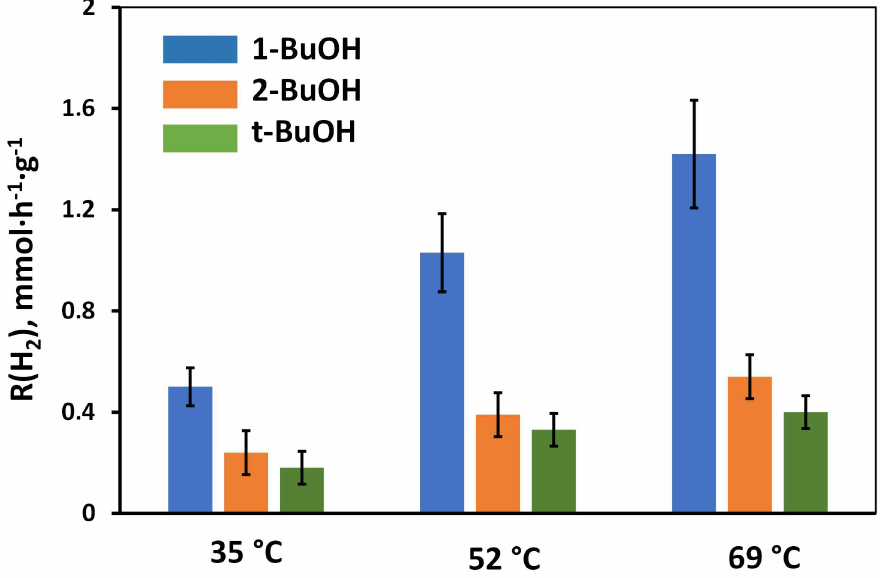
Figure 3. Rate of H 2 production as a function of bulk temperature from 0.5 M aqueous solutions of BuOH isomers irradiated with an Xe lamp (vis/NIR: 8.4 W, UV: 0.6 W) under Ar flow in the presence of Ti@TiO 2 NPs. Table 1. The apparent activation energy of H 2 photocatalytic formation for BuOH isomers (0.5 M)